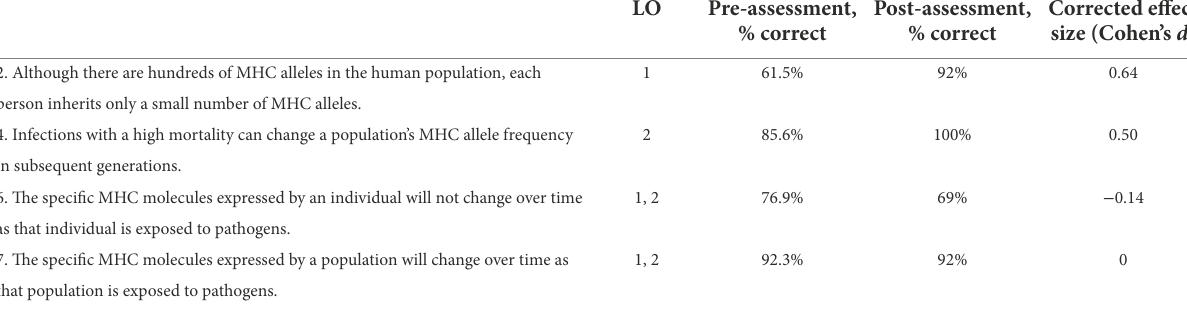
TABLE 1 Learning gains in students completing the MHC haplotype activity.